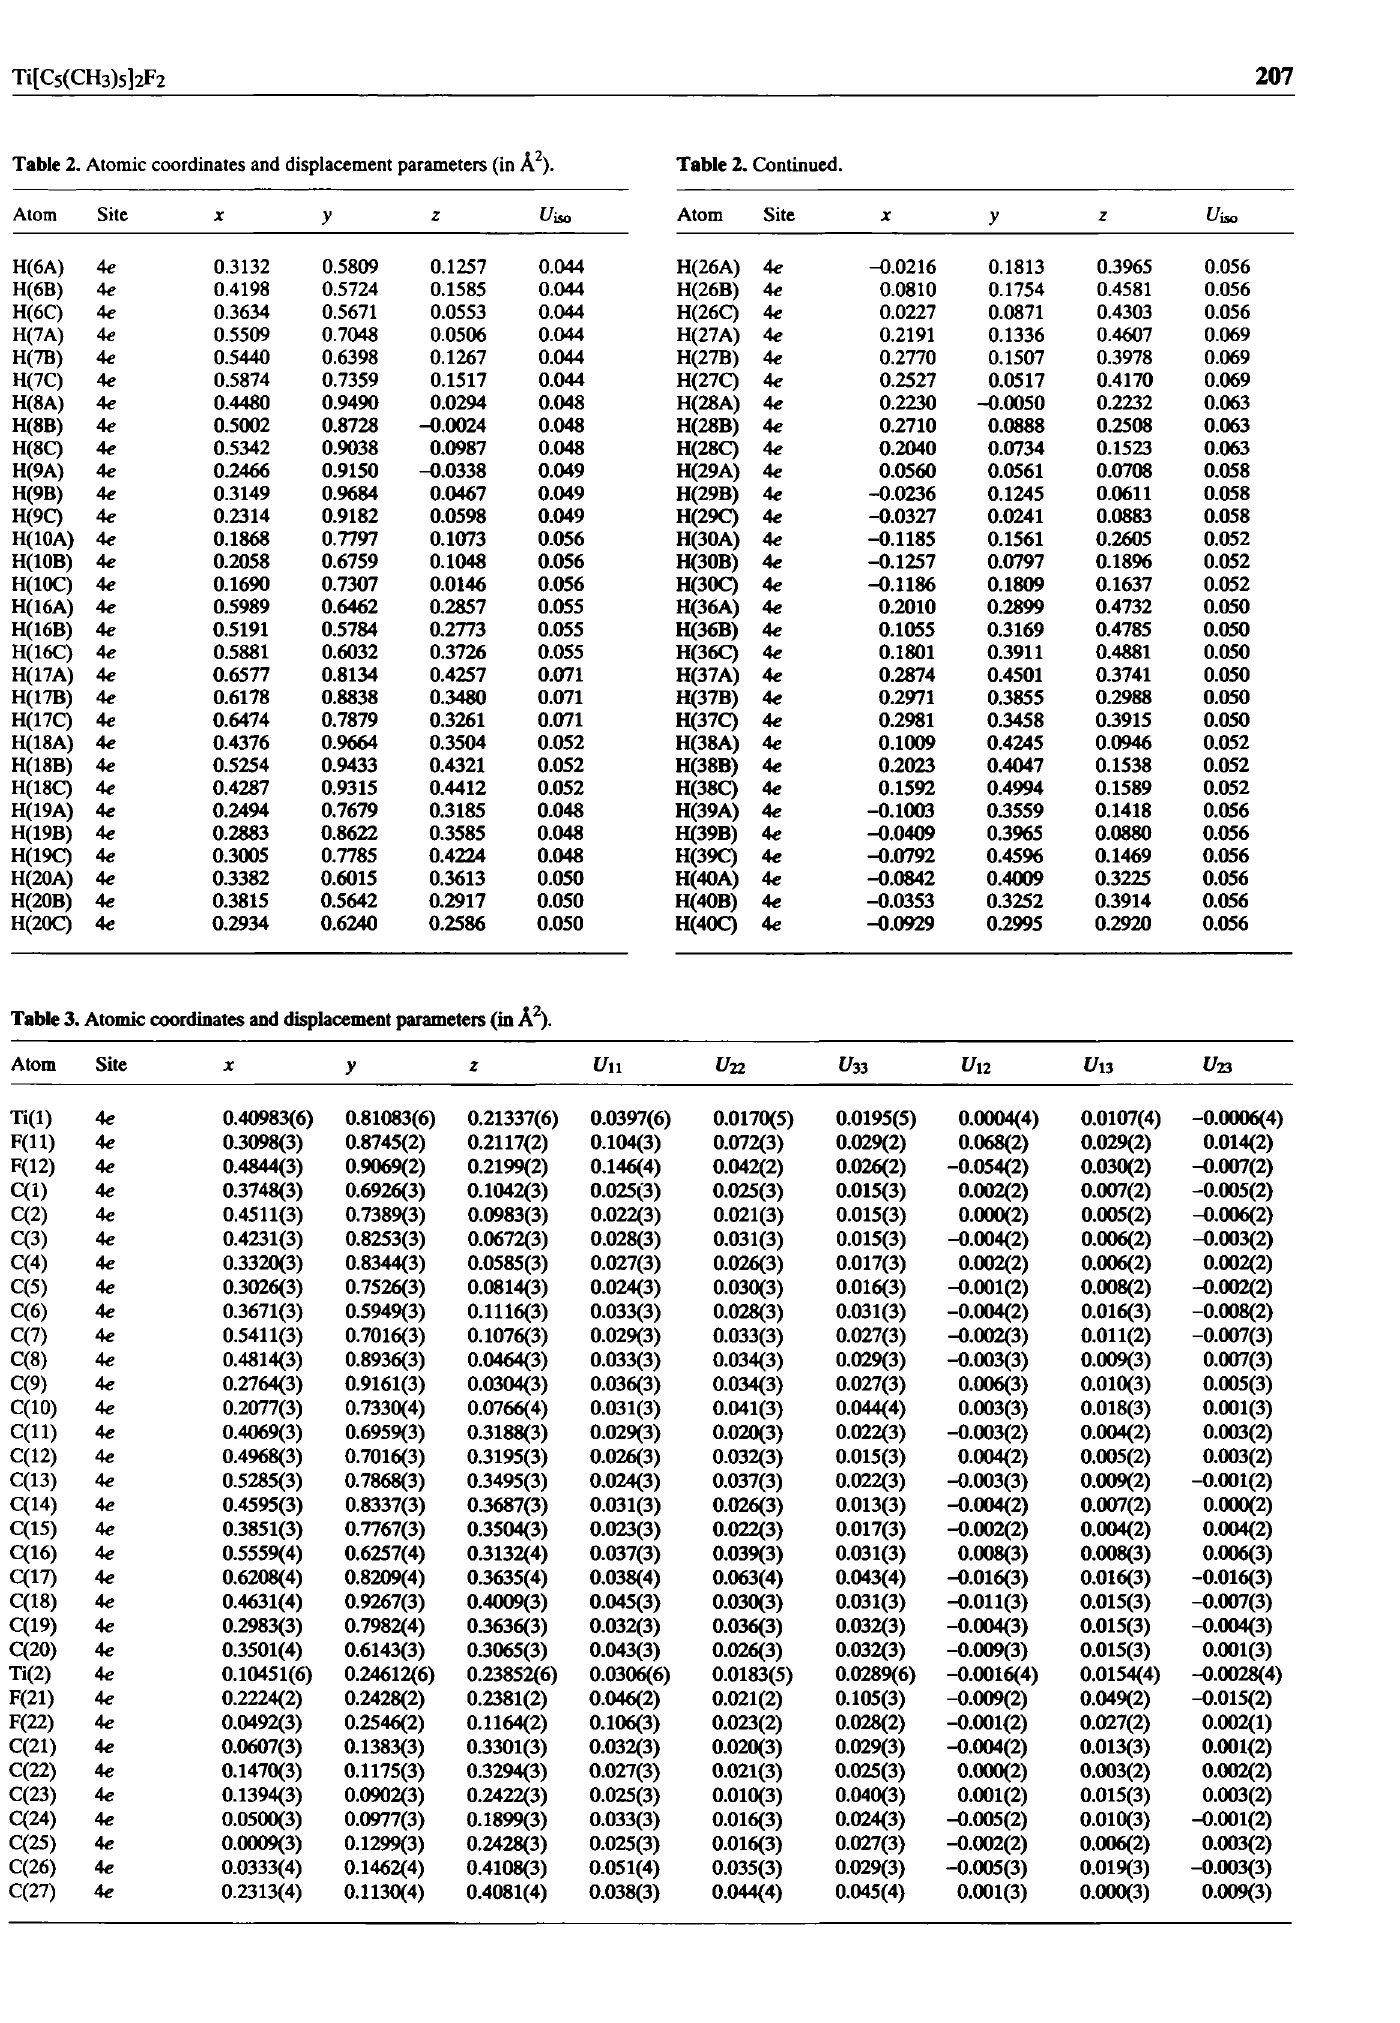
Table 3. Atomic coordinates and displacement parameters (in A 2